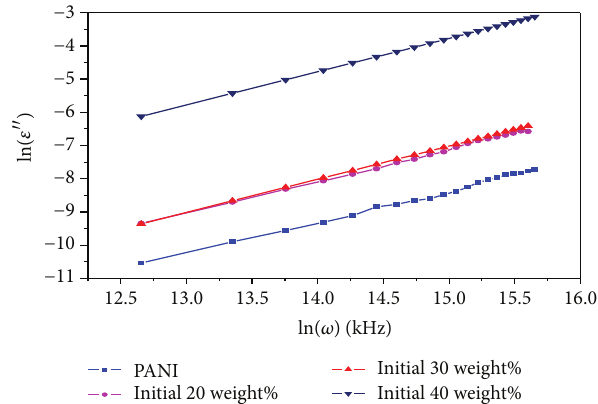
Figure 6: ln (𝜀 󸀠󸀠 ) versus ln (𝜔) at fixed temperature for pure PANI and PANI/V 2 O 5 (different wt%). Table 2: Temperature dependence of slope ( 𝑚 ) and DC conduction loss of pure PANI and PANI/V